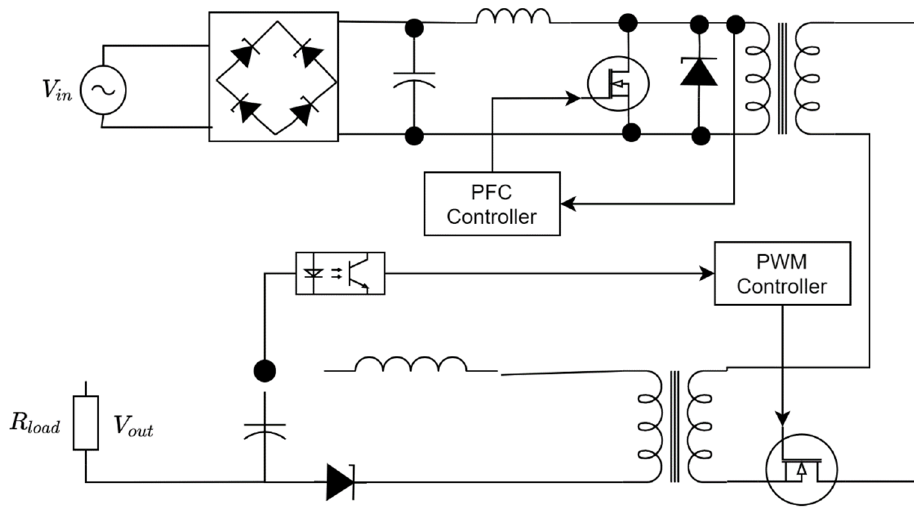
Figure 1. The topology of a typical SMPS.